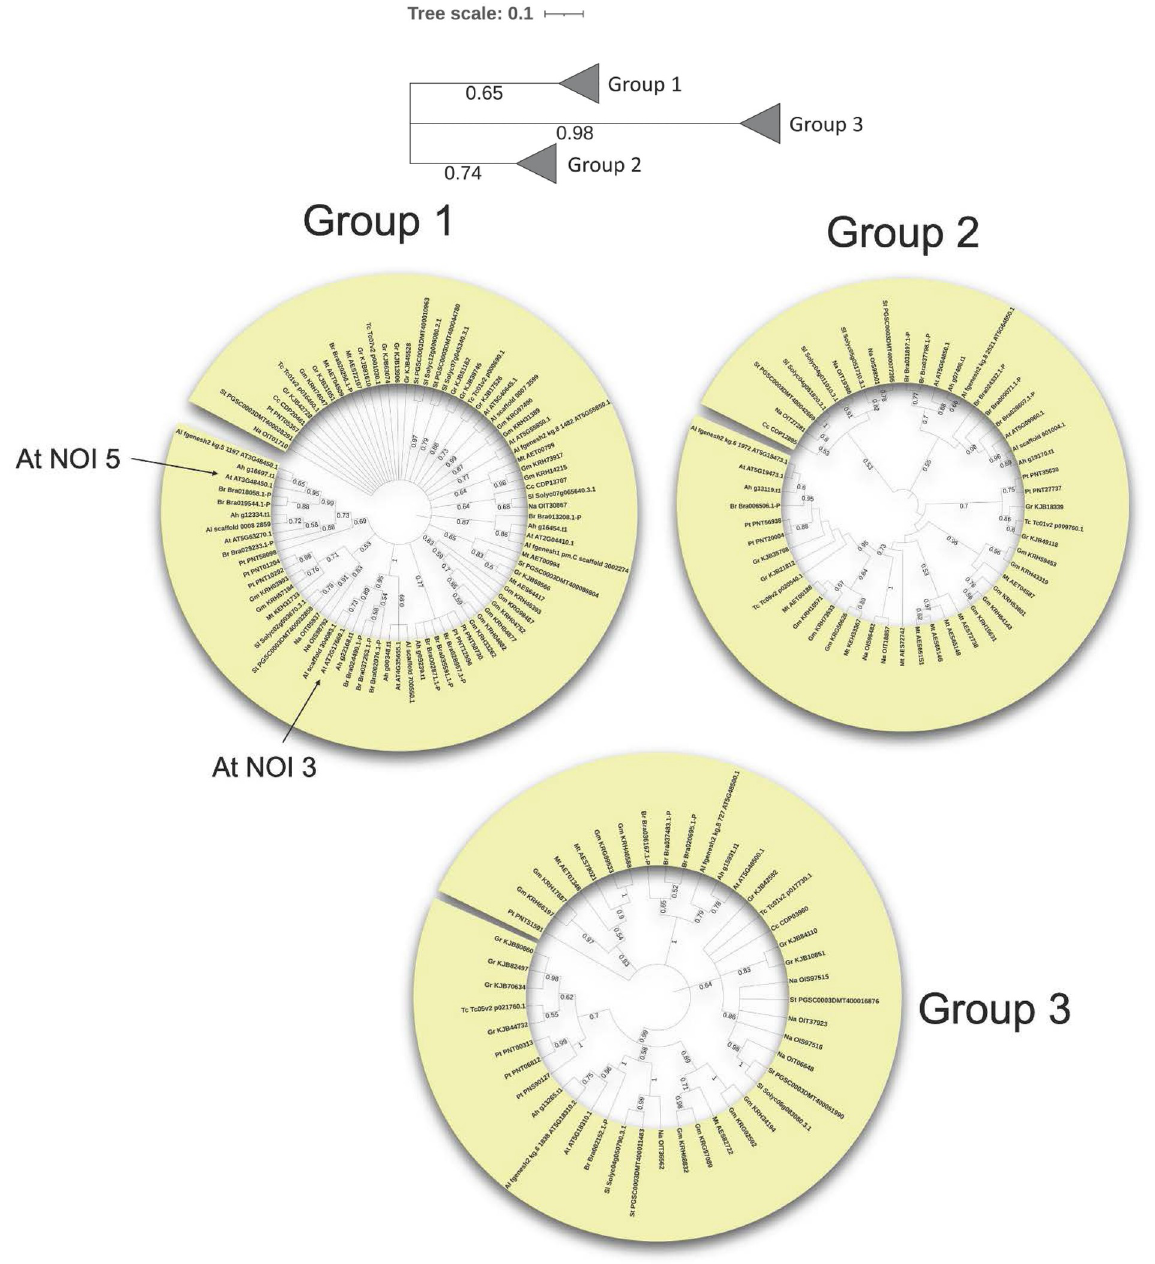
Fig 2. Phylogenetic trees of RIN4-like/NOI family short two-NOI proteins. A schematic tree for all dicot sequences and the individual group phylogenies are showed. The position in the tree of A . thaliana RIN4-like/NOI members upregulated after mite feeding is indicated. Bootstrap values are